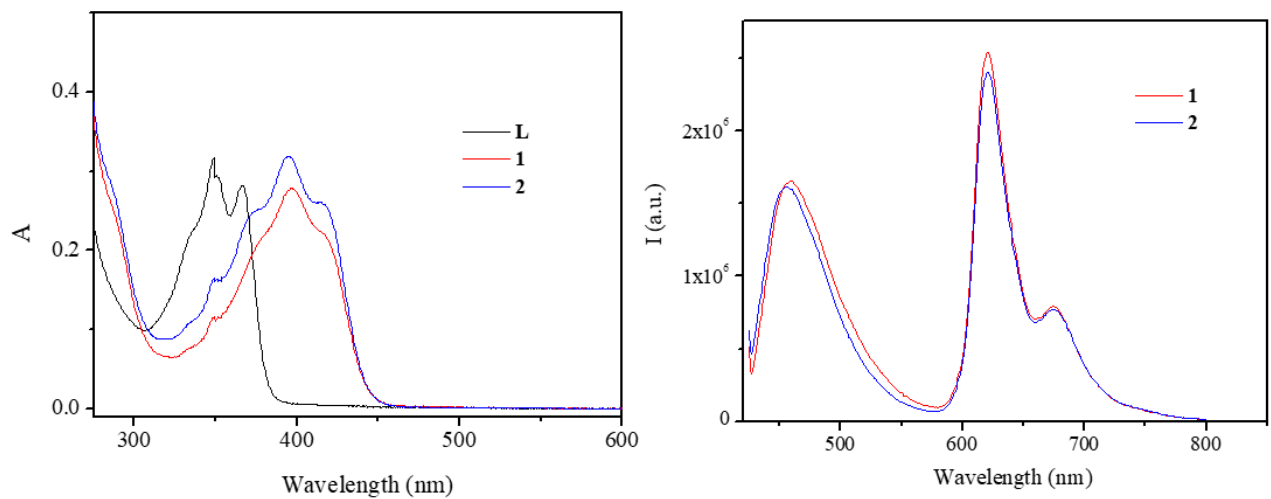
Figure 1. Absorption ( left ) and emission ( λ exc = 418 nm, right ) spectra of L and complexes 1 and 2 in DMSO.